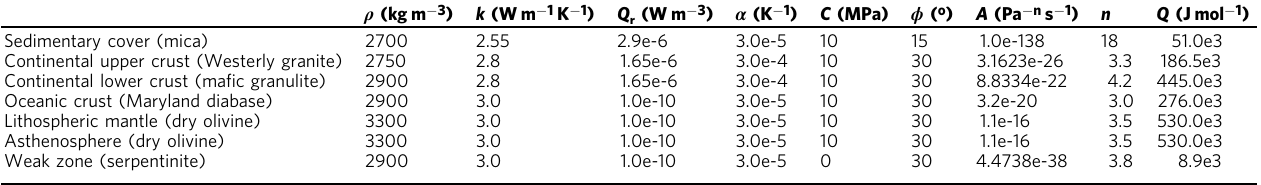
Table 1 Thermal and rheological parameters used for different compositions in the reference model.